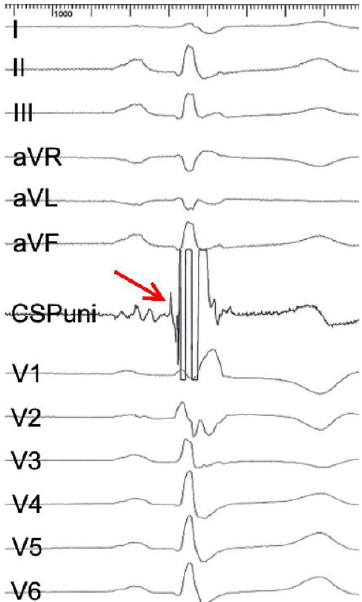
Figure 4. 12-lead ECG from a patient, who underwent LBBAP lead implantation. The unipolar electrogram (CSPuni) shows a left bundle branch potential during intrinsic rhythm, which is indicative of successful positioning of the lead in the specific conduction system (arrow).